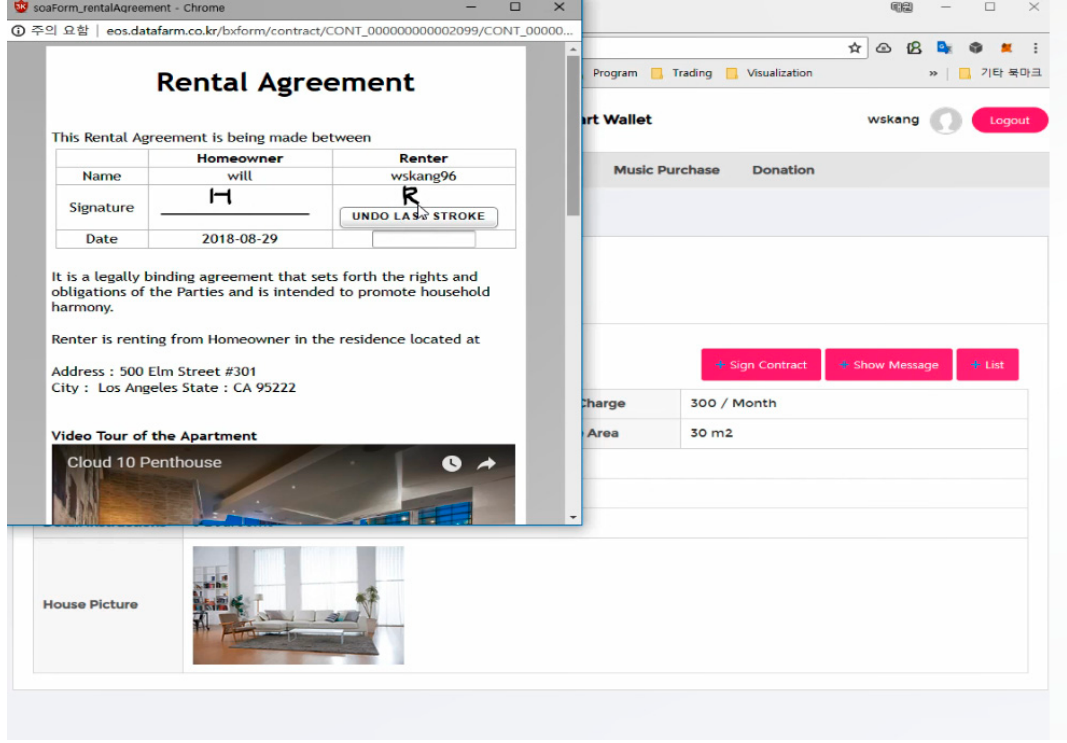
Figure 15. Blockchain smart contracts for real estate transactions.